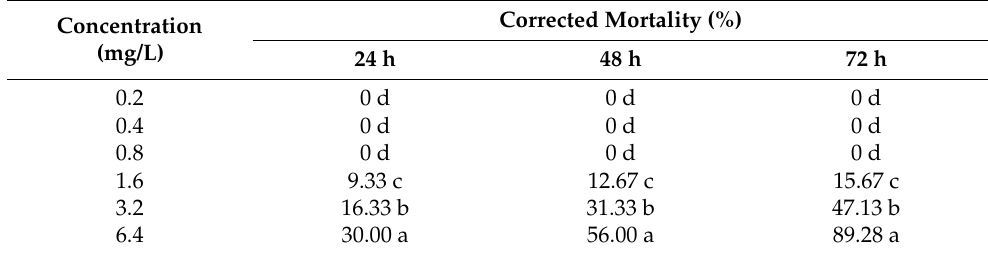
Table 1. Immersion toxicity effect of different concentrations of Pedunsaponin A on P. canaliculata .